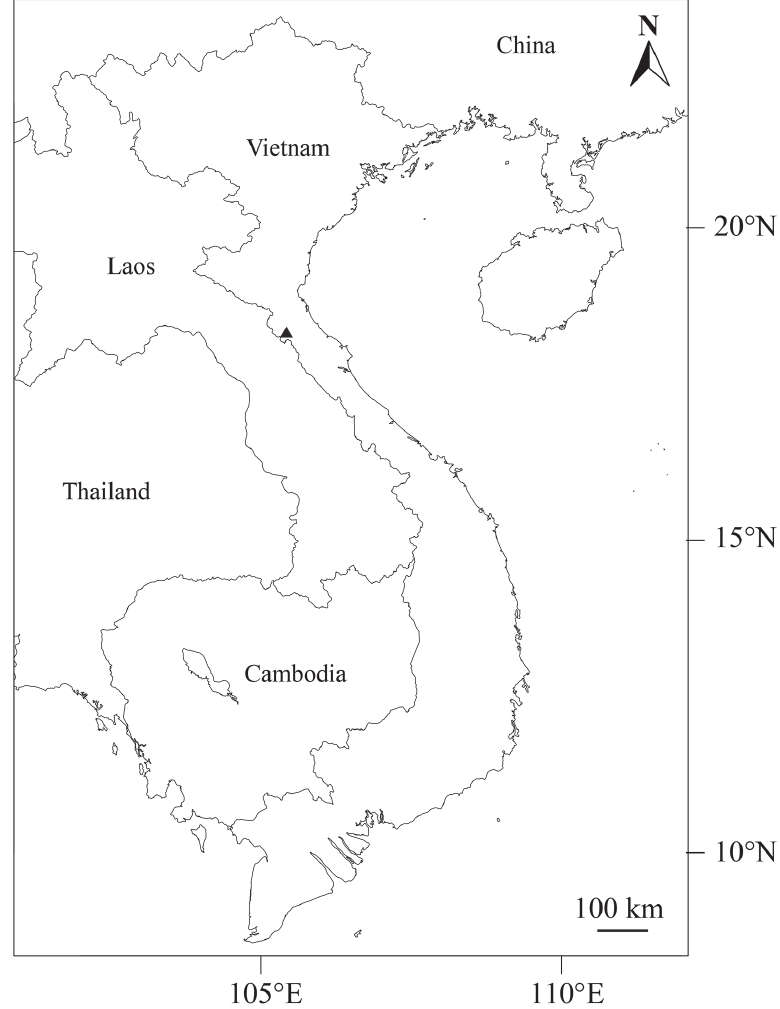
Figure 1. Location of Vu Quang National Park (Black triangle), type locality of Lithocarpus vuquangensis DNA extraction and sequencing